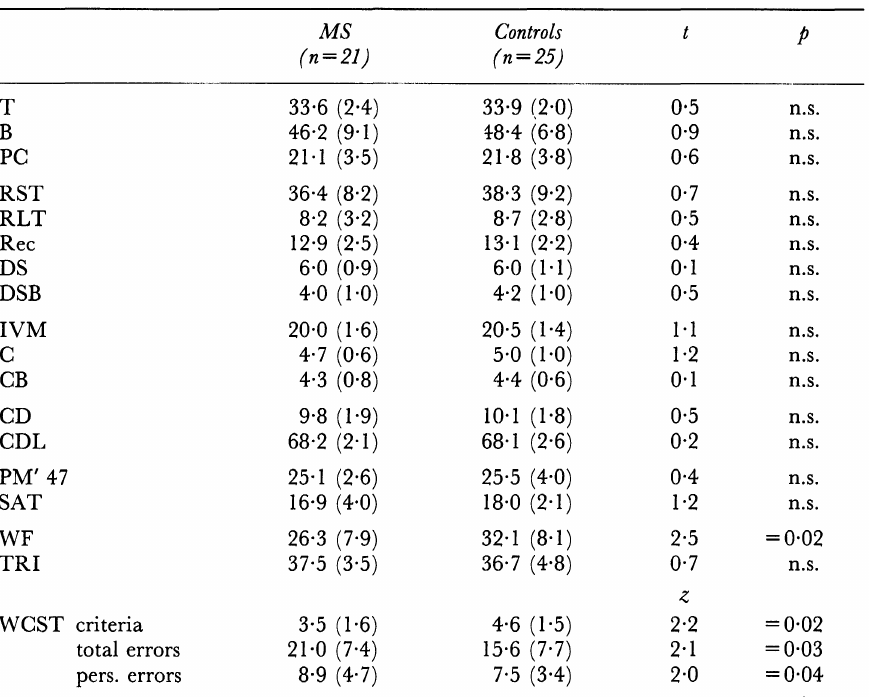
TABLE 6. Performance scores obtained on various tests rif neuropsychological battery by non-demented MS and control